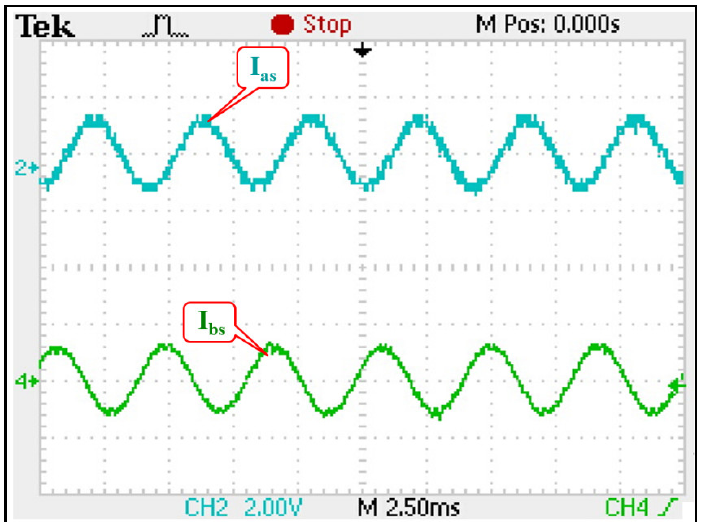
Figure 20. Measured line currents I as and I bs at a sampling frequency of 100 kHz and a rotation frequency of 1200 rpm for a three–phase IM.